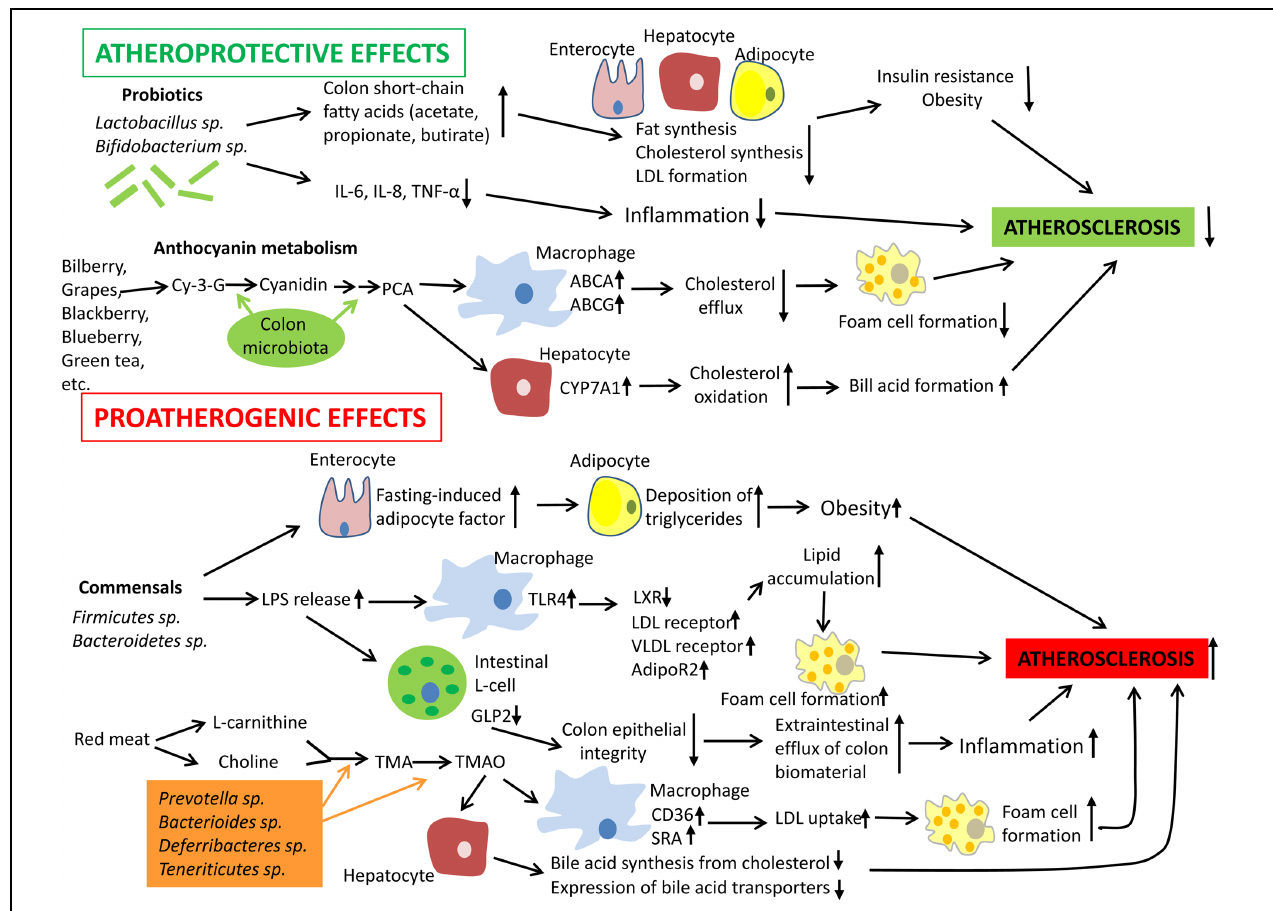
FIGURE 1 | Mechanisms by which gut microbiota could influence the development of atherosclerosis. Intestinal microbiota may have both pro- and anti-atherogenic effects. Probiotics have the atheroprotective activity through the release of bioactive short-chain fatty acids that in turn inhibit fat synthesis in adipocytes and enterocytes and suppress cholesterol biosynthesis and formation of proatherogenic low density lipoproteins (LDL) in the liver. In addition, probiotics and their products could down-regulate inflammation thereby indirectly decreasing the atherosclerosis progression. In addition, anthocyanins presented in some barriers, fruits, and green tea could be metabolized by colon microflora to protocatechuic acid (PCA), a bioactive molecule that could increase expression of ATP-binding cassette transporters ABCA and ABCG and in macrophages and therefore stimulate cholesterol efflux and inhibit macrophage transformation to foam cells, a hallmark of early atherosclerosis. PCA could stimulate cholesterol catabolism and bile acid synthesis via up-regulation of liver cholesterol 7 α -hydroxylase CYP7A1, an enzyme, which oxidizes cholesterol. However, gut microbiota could also exhibit proatherogenic effects. Commensal bacteria such as Firmicutes sp. and Bacteroidetes sp. release lipopolysaccharides (LPS) that could be recognized by Toll-like